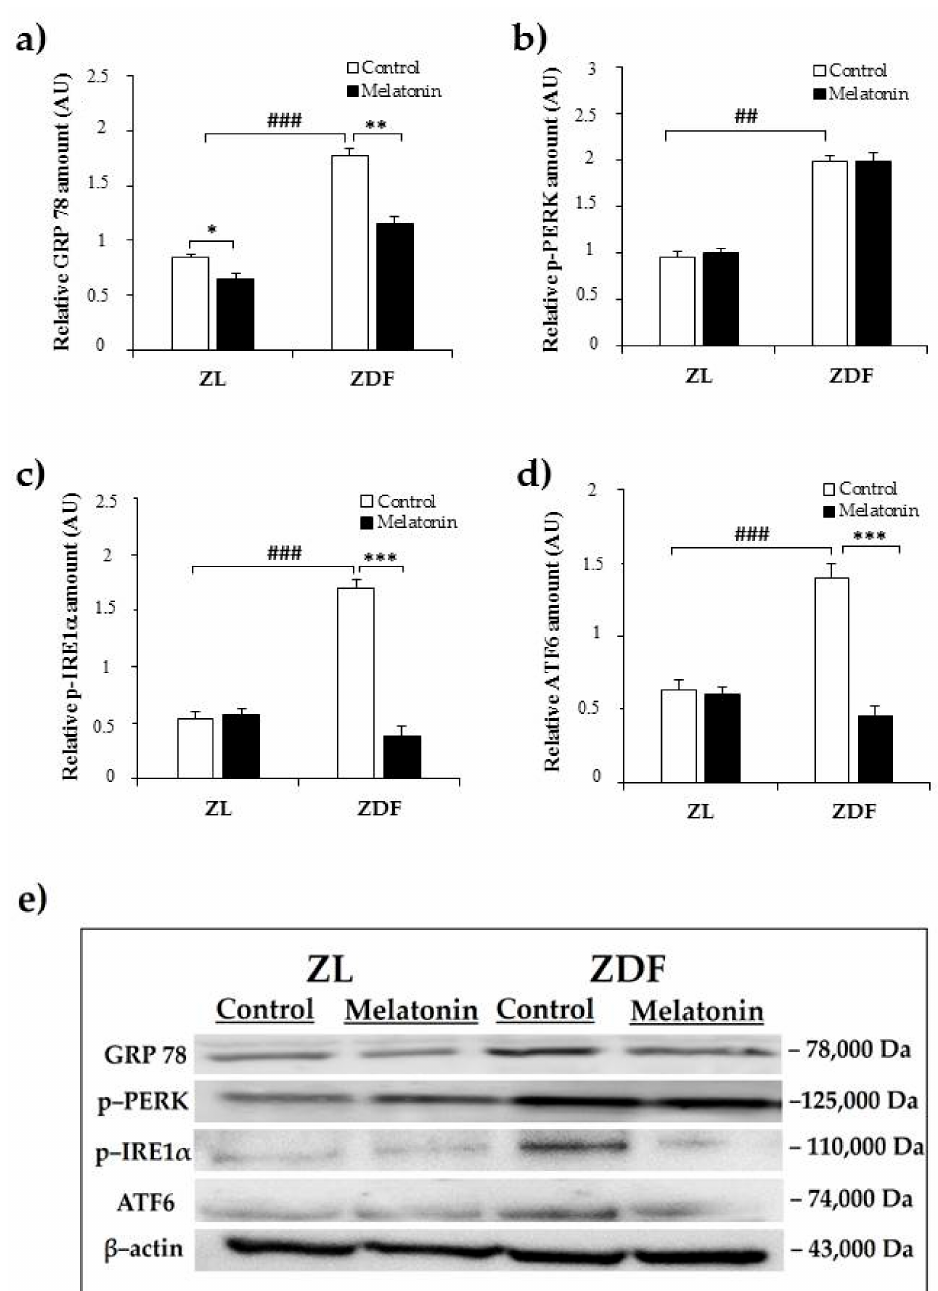
Figure 1. Effects of melatonin supplementation on endoplasmic reticulum (ER) stress markers in the kidney of Zücker lean and diabetic fatty rats as measured by Western blot. ( a – d ) Densitometry quantification of glucose-regulated protein 78 (GRP78) p–protein kinase RNA–like endoplasmic reticulum kinase (PERK), p–inositol-requiring enzyme1 α (IRE1 α ), and ATF6 protein levels. ( e ) Repre- sentative blot of GRP78, phospho–PERK, phospho–IRE1 α , and ATF6. C–ZL: control lean rats without melatonin; M–ZL: lean rats with melatonin; C–ZDF: control diabetic fatty rats without melatonin; M–ZDF: diabetic fatty rats with melatonin; ZL: Zücker lean rats; ZDF: Zücker diabetic fatty rats. Values are means ± S.E.M ( n = 3) of ratios of specific protein levels to β –actin (Loading protein). ## p < 0.01, ### p < 0.001 C–ZDF vs. C–ZL; * p < 0.05 M–ZL vs. C–ZL; ** p < 0.01, *** p < 0.001 M–ZDF vs. C–ZDF (Tukey post hoc